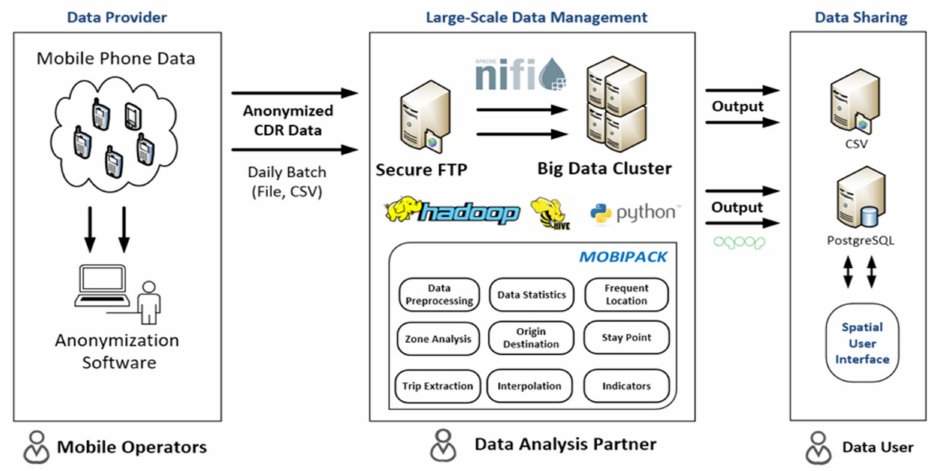
Figure 1. The overall structure of the data-analytics